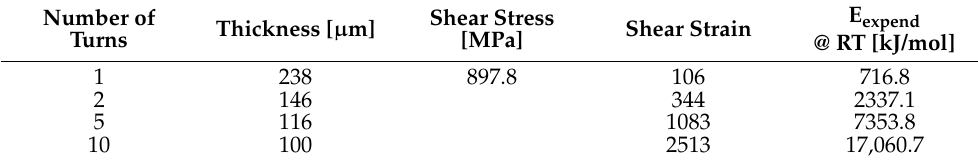
Table A2. Expended energy E exp estimated from torque measurements done during HPT, for alloy B. Number of